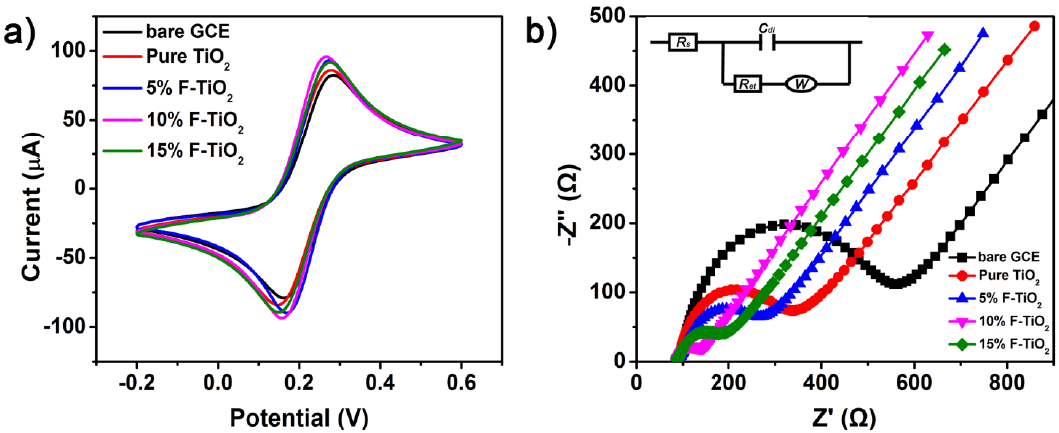
Figure 7. ( a ) CV and ( b ) EIS analysis of the pure TiO 2 , 5% F–TiO 2 , 10% F–TiO 2 , and 15% F–TiO 2 modified GCEs in the solution of 5 mM Fe(CN) 63−/4− containing 0.1 M KCl. The corresponding results of the bare GCE are also included for reference. The inset in Figure 7b is the equivalent circuit.